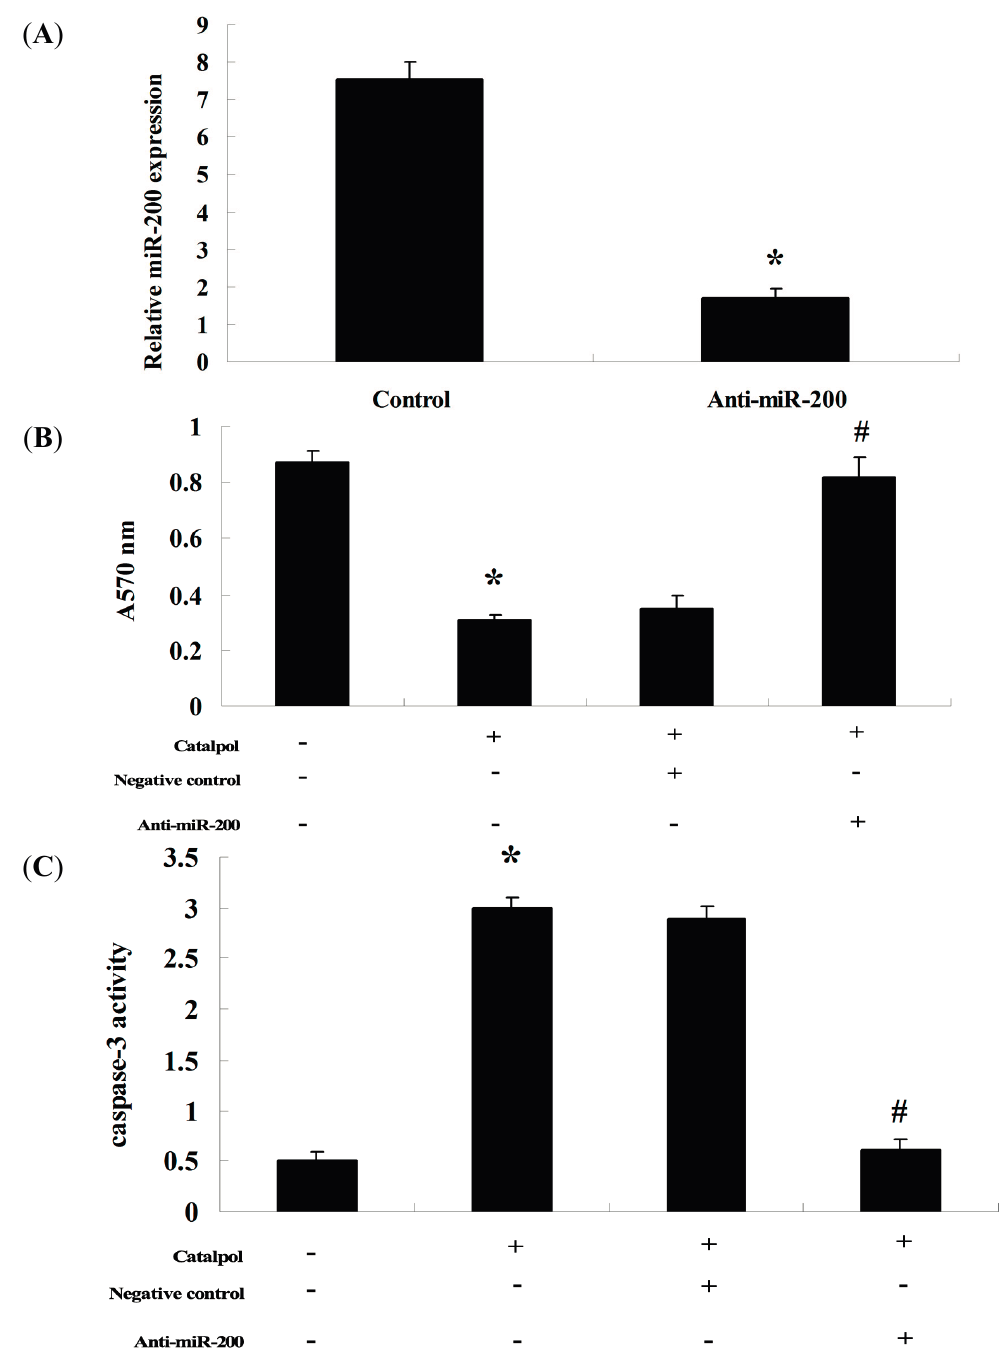
Figure 7. Anti-miR-200 can reverse the effect of catalpol. Anti-miR-200 could evidently decrease the expression of miR-200 in OVCAR-3 cells ( A ); After treatment with catalpol (50 μ g/mL) for 48 h, anti-miR-200 significantly promoted the cell proliferation of OVCAR-3 cells ( B ); After treatment with catalpol (50 μ g/mL) for 48 h, anti-miR-200 evidently inhibited cell apoptosis of OVCAR-3 cells ( C ) and the anti-miR-200 significantly increased MMP-2 activity in OVCAR-3 cells after catalpol (50 μ g/mL) treatment at 48 h ( D ). * p < 0.01 compared with 0 mg/mL catalpol treatment group, and # p < 0.01 compared with catalpol-treated group transfected with negative